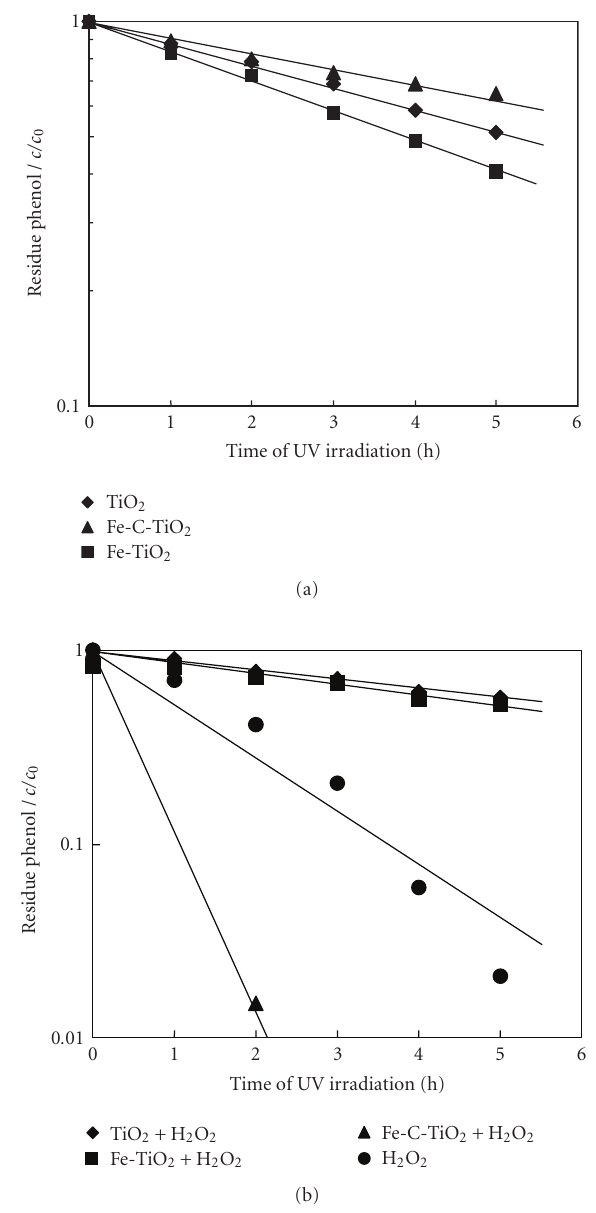
Figure 17: Phenol decomposition on TiO 2 , Fe-TiO 2 , and Fe-C- TiO 2 prepared at 500 ◦ C, (a) under UV and (b) under UV with H 2 O 2 .